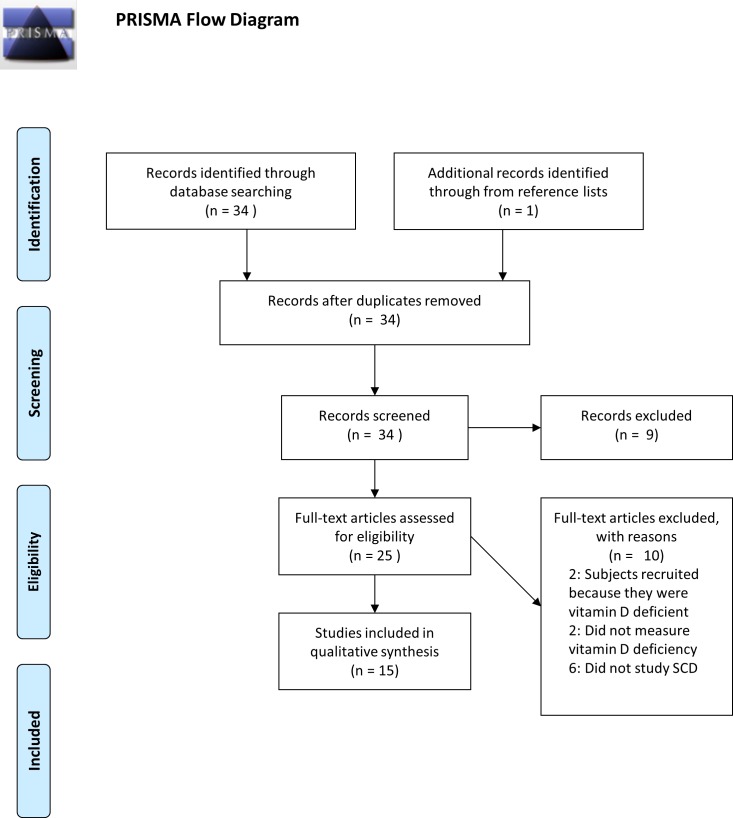
PRISMA Flow Diagram.Flowchart of publications included in this systematic review.